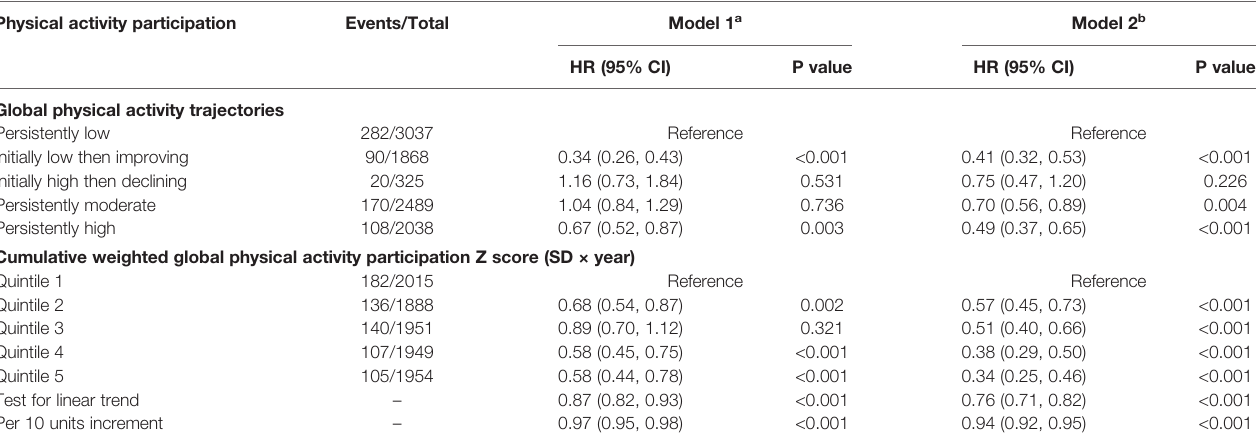
TABLE 3 | Association of long-term physical activity participation on subsequent incident DM.